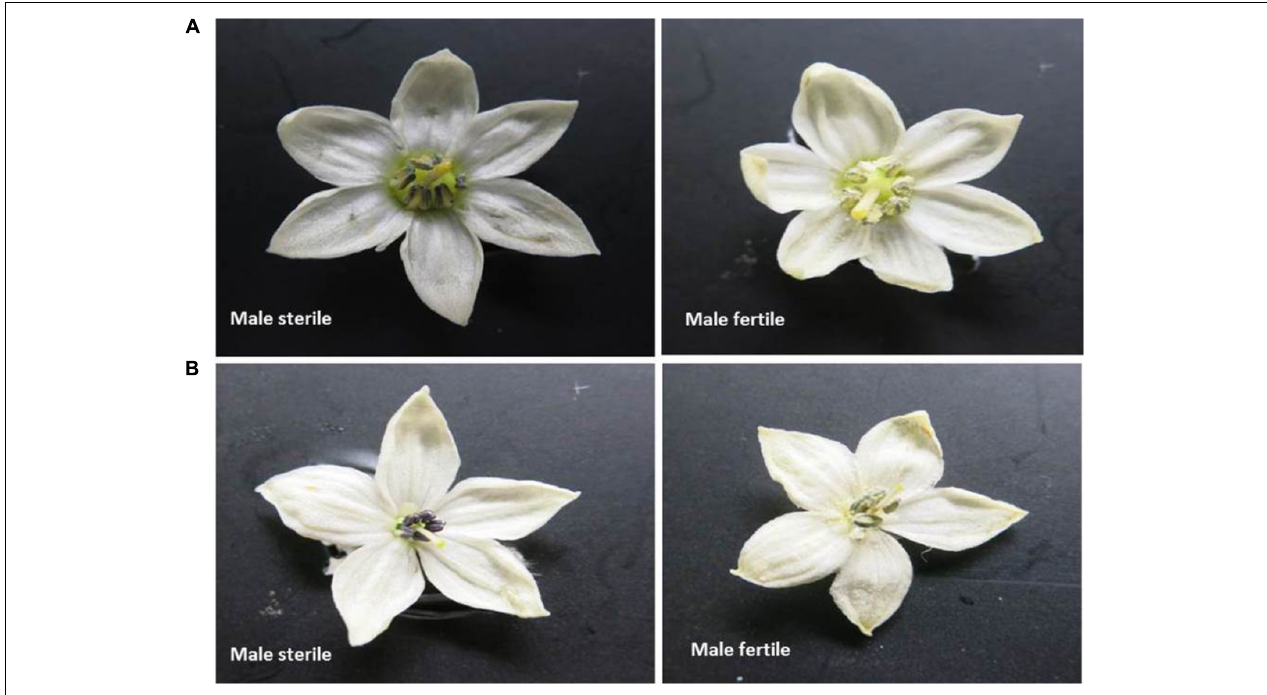
FIGURE 1 | Flowers of male sterile and male fertile plants. (A) Sweet pepper, (B) Hot pepper.